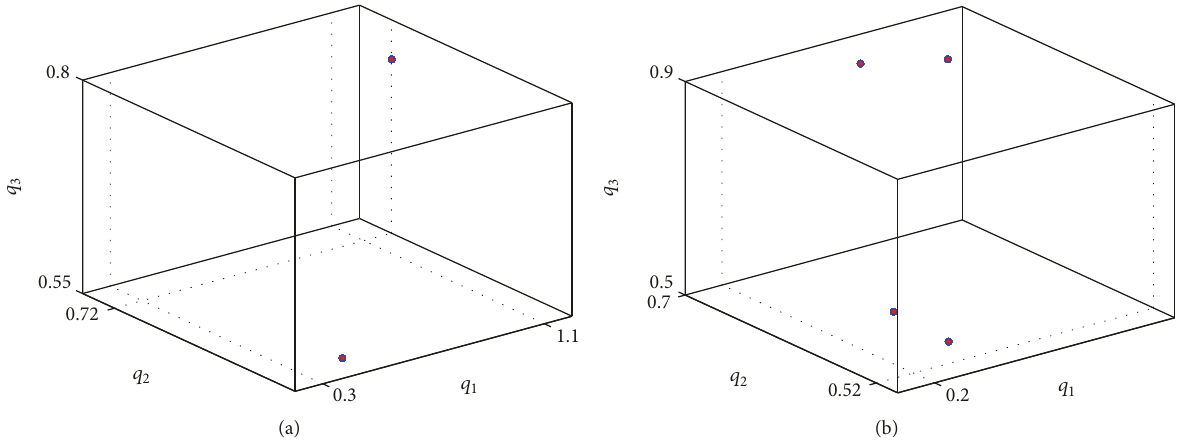
Figure 3: (a) Phase portrait for 2 cycles at 𝑘 1 = 8.5 , 𝑘 2 = 5 , 𝑘 3 = 7 , 𝑐 1 = 0.19 , 𝑐 2 = 0.18 , and 𝑐 3 = 0.17 . (b) Phase portrait for 4 cycles at 𝑘 1 = 9 , 𝑘 = 5 , 𝑘 = 7.5 , 𝑐 = 0.19 , 𝑐 = 0.18 , and 𝑐 = 0.17 2 3 1 2 3